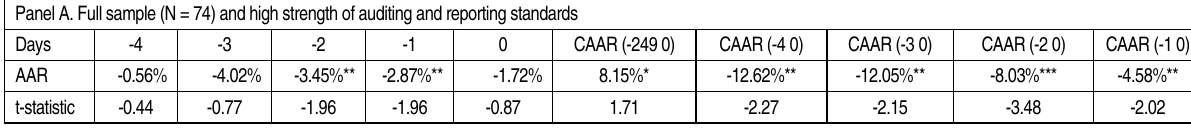
Table 3. Average abnormal returns and cumulative average abnormal returns around delistings announce- ment days, based on the strength of auditing and reporting